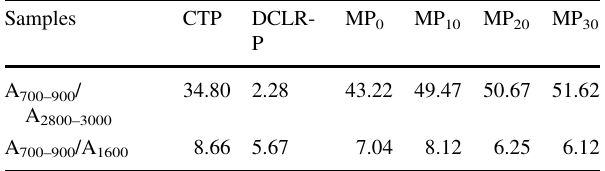
Table 5 Structure parameters of FTIR spectra of DCLR-P, CTP and MP Samples